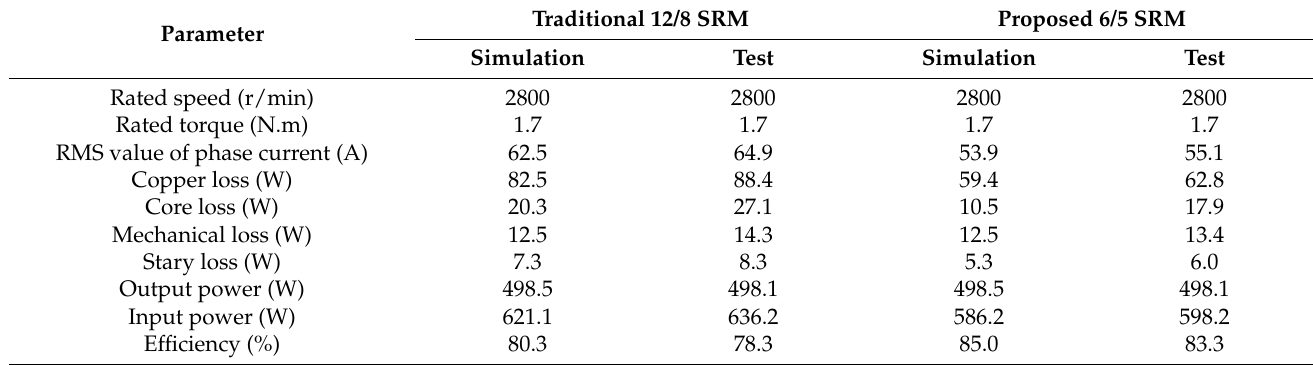
Table 3. Steady-state characteristics comparison of the two motors under rated operating condition in